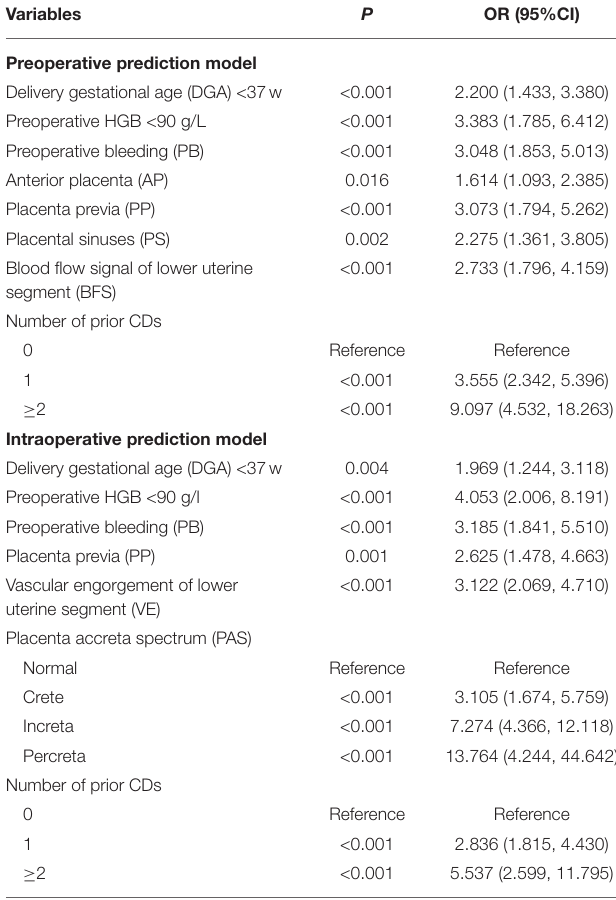
TABLE 3 | Multivariate logistic regression in the development